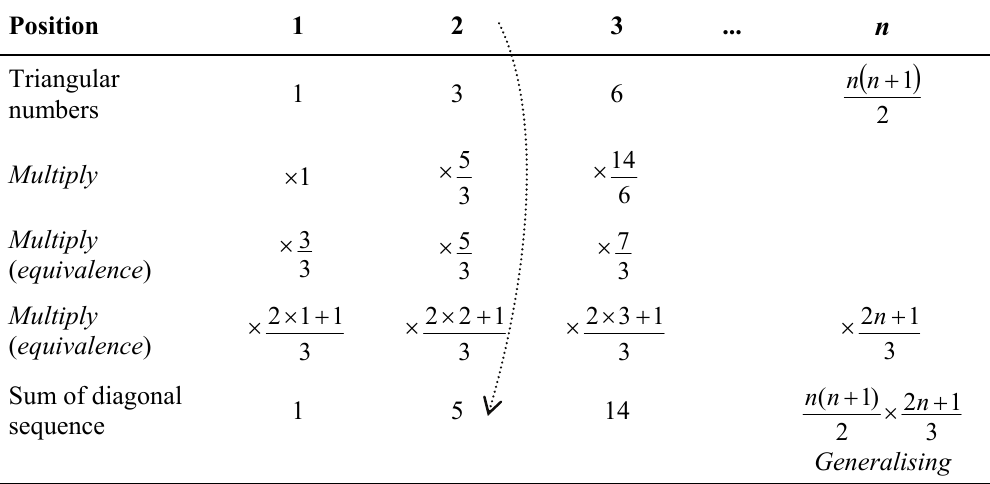
Figure 8 : Generating a formula for summing the square numbers